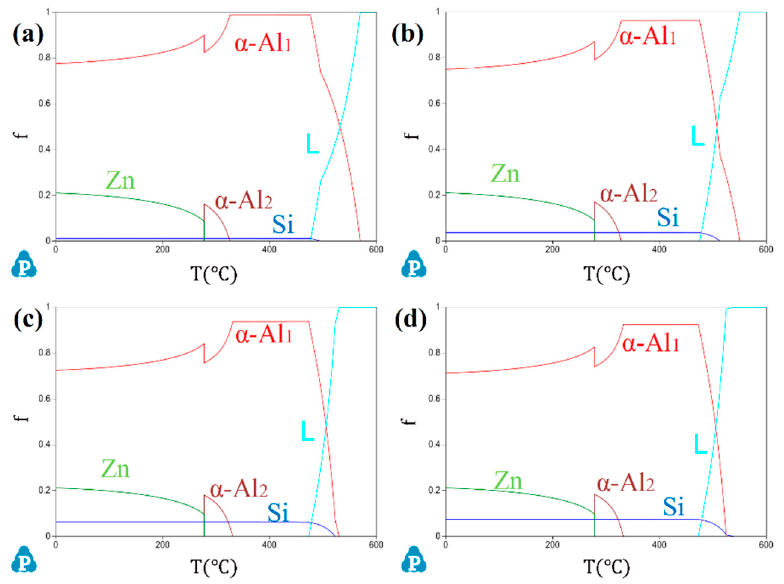
Figure 2. Phase fraction variation with temperature for Al-40Zn-xSi gold under equilibrium solidification calculated by Pandat software: ( a ) Al-40Zn-1Si, ( b ) Al-40Zn-3Si, ( c ) Al-40Zn-5Si, ( d ) Al-40Zn-6Si.